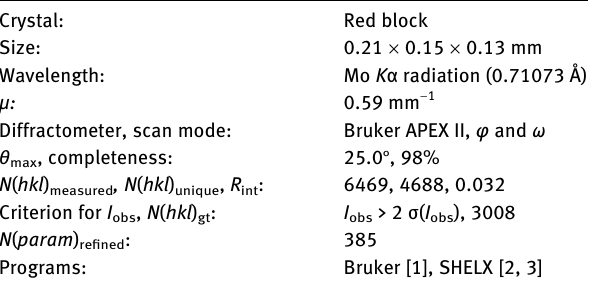
Table  : Data collection and